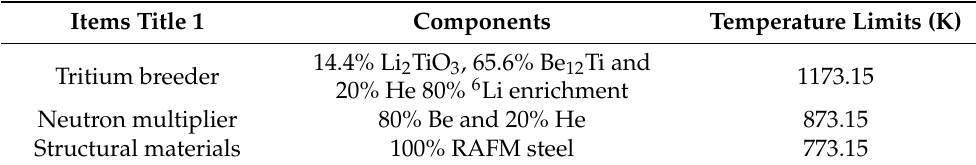
Figure 1. The structure of the blanket. Table 3. Boundary conditions. Table 1. The materials adopted in the blanket. Reprinted with permission from [6]. Copyright 2018